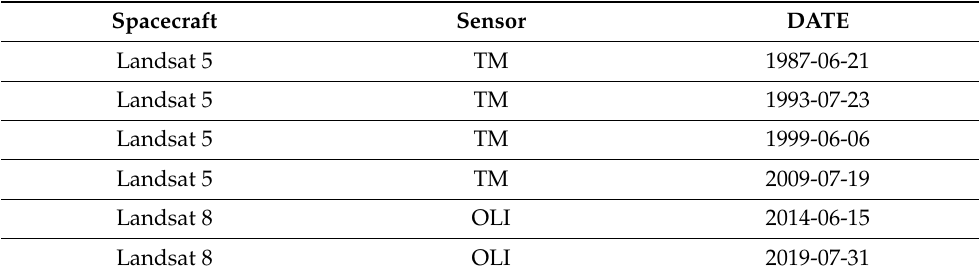
Table 1. Satellite images used in the research *.